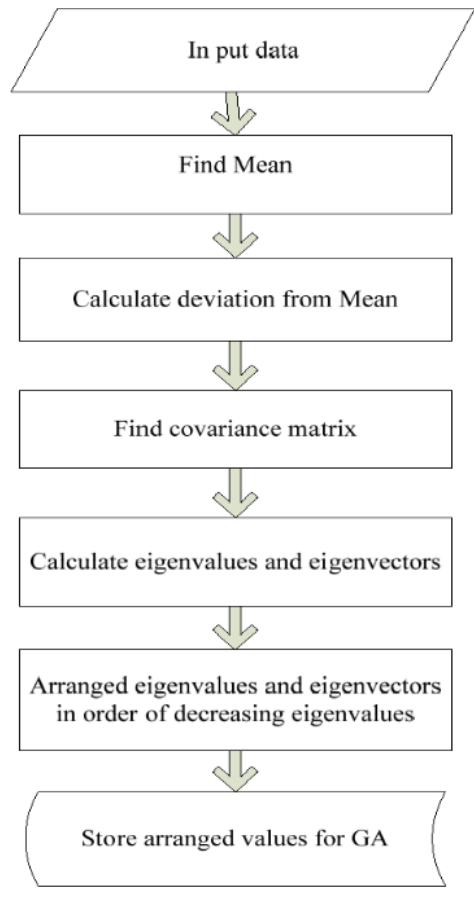
Figure 1 . PCA based approach for feature selection Several existing intrusion detection systems, namely User-to-Root (U2R) and Remote-to-Local (R2L) attacks, are weak in detecting low frequency attacks. Studies prove that they can be detected by employing a hybrid approach. Hence, a hybrid system using Principal Component Analysis (PCA), Network Behaviour Analysis (NBA) and Genetic Algorithm (GA) has been adopted for achieving high efficiency in detecting both high-frequent and low-frequent